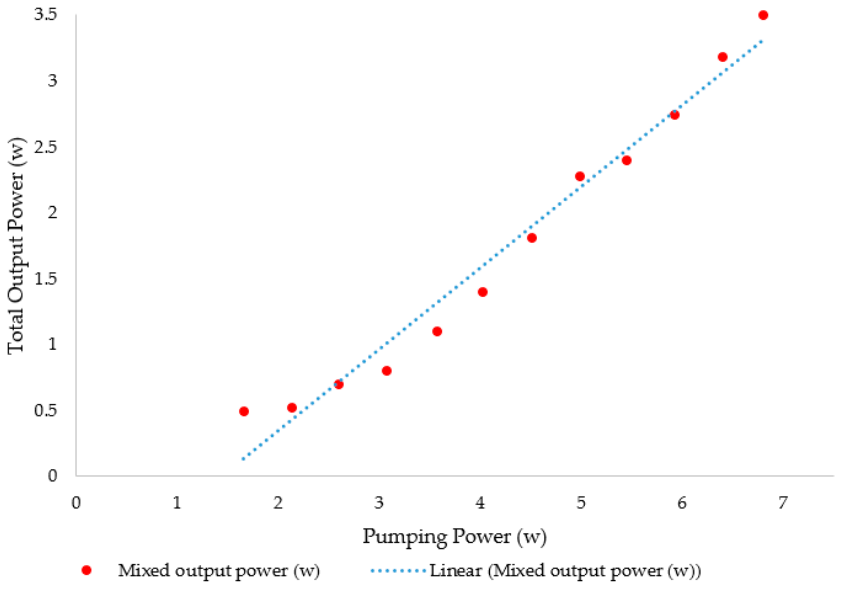
Figure 7. The measured total output power versus input pump power for σ - π configuration.